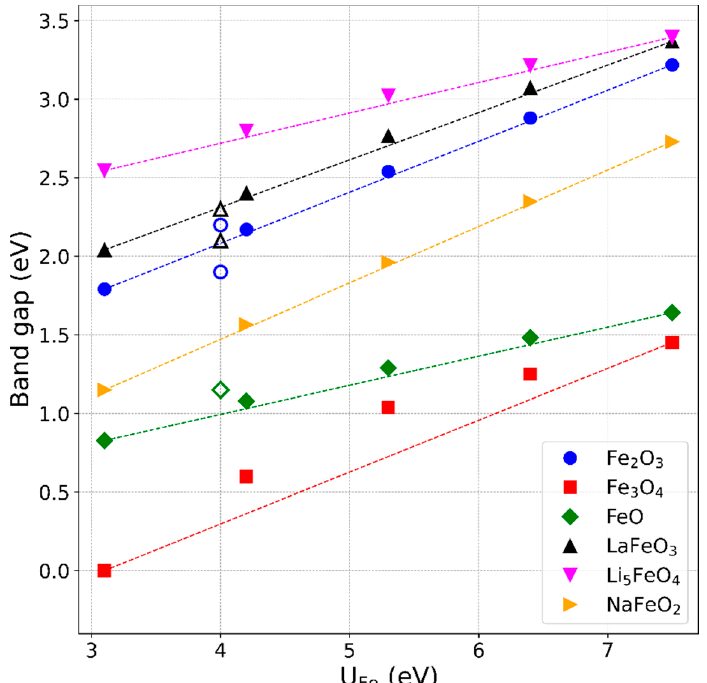
Figure 3. Calculated band gap energies as functions of U . Filled symbols: band gaps of iron-oxide compounds calculated with DFT+ U for different U values. The lines connect the two outer data points, indicating a more-or-less pronounced upwards shift of the values around U ≈ 5.3 eV. Open symbols, exemplarily displayed at U = 4 eV, represent experimental band gap values of the respective compounds [45–49].